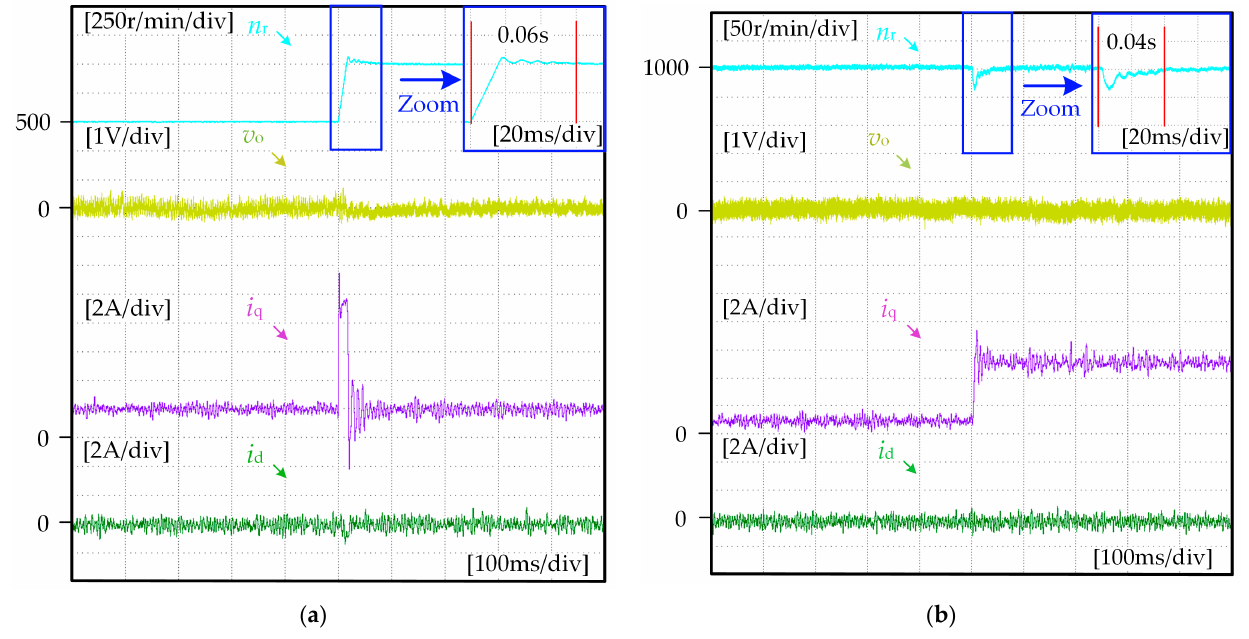
Figure 13. Transient Performance of ECS-MPCC strategy. ( a ) Speed step response; ( b ) Torque